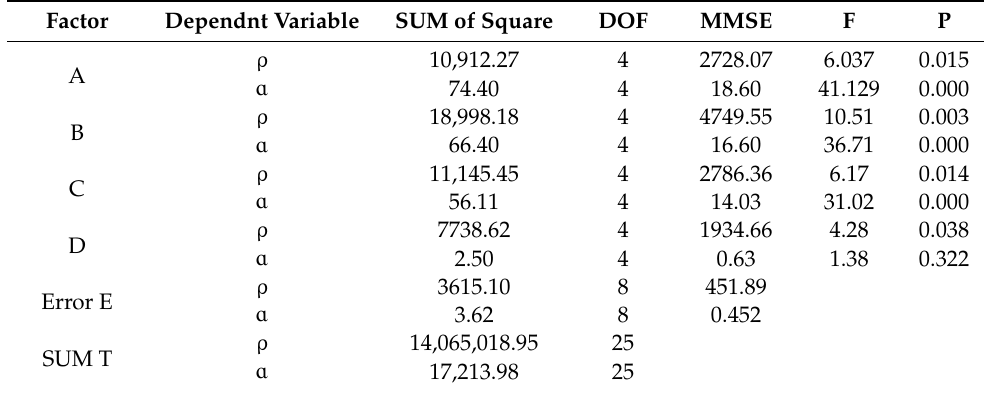
Table 5. Analysis of variance.